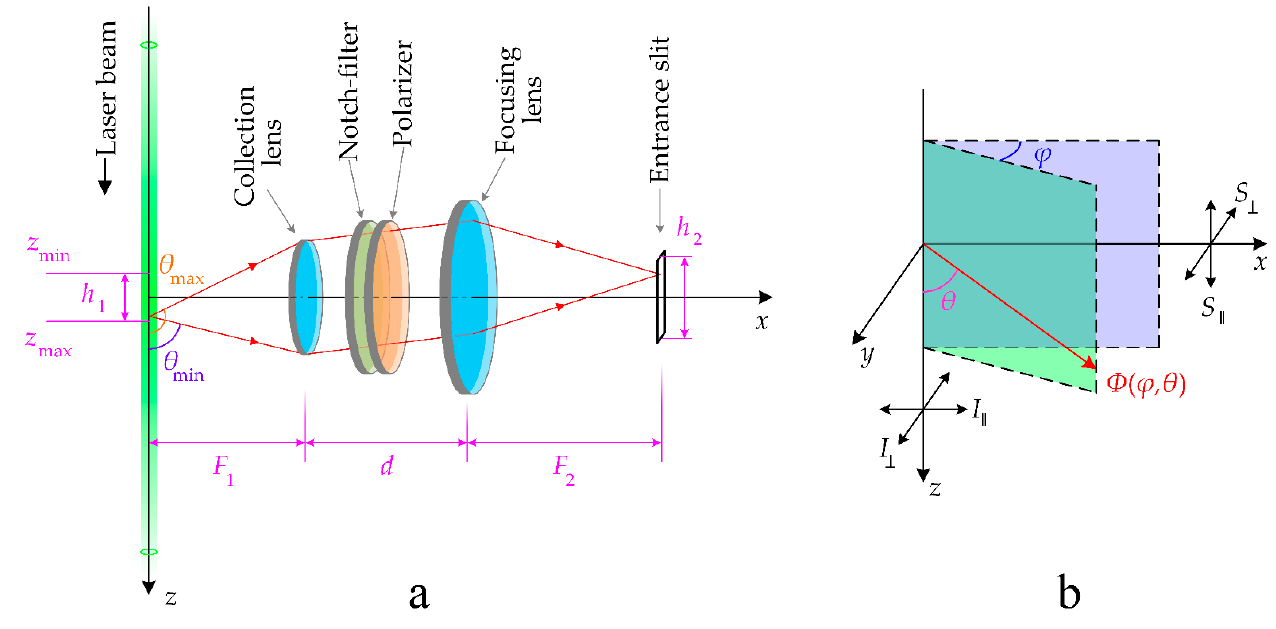
Figure A1. Sketch ( a ) is the optical collection system of the scattered radiation. The laser beam propagates along the z-axis, the scattered radiation is collected along the x-axis. Here, the path of two light rays from an arbitrary point z at an angle ϕ = 0 is shown. Sketch ( b ) is the definition of scattering angles, where I ⊥ and I denote the polarization directions of the incident radiation, S ⊥ and ⊥ (cid:107) the polarization planes of the scattered radiation, ϕ is the angle between the scattering plane (green) and the plane S (blue), and θ is the angle between the z-axis and the direction of scattering Φ ( ϕ , θ ) in (cid:107) the scattering